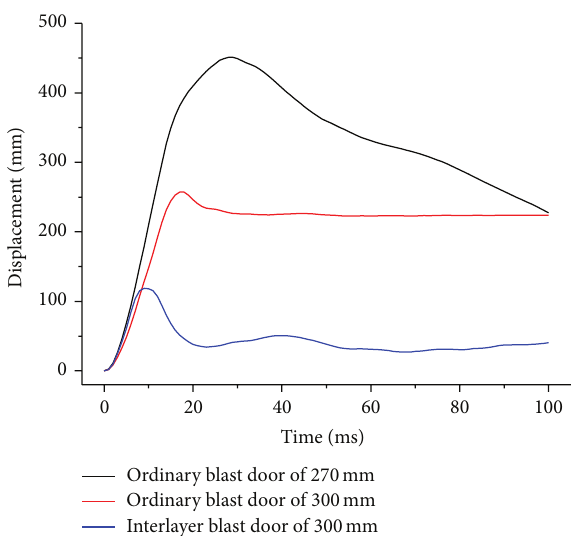
Figure 9: History curve of midspan displacement of different doors.